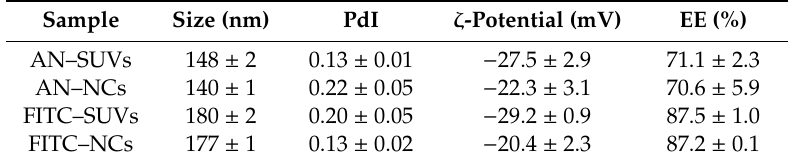
Table 3. Physical and chemical characterisation of AN- and FITC-loaded LPs and NCs. Sample